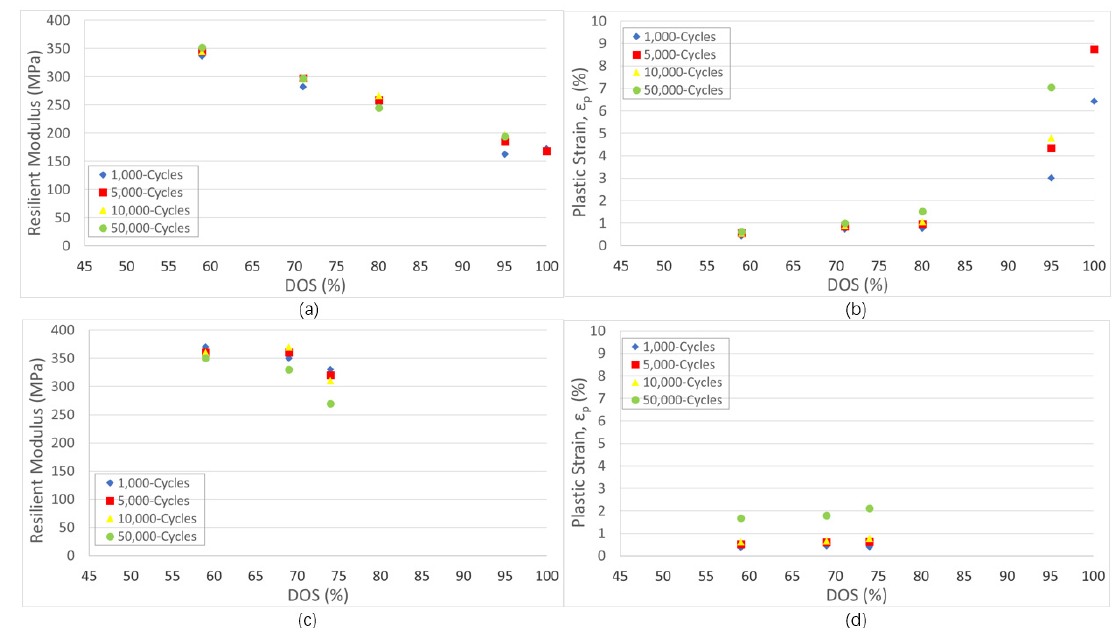
Figure 7. The relationship between the repeated load triaxial test (RLT) test results and DOS at a different number of cycles: ( a ) resilient modulus with applied deviator stress of 425 kPa; ( b ) plastic deformation with applied deviator stress of 425 kPa; ( c ) resilient modulus with applied deviator stress of 625 kPa; and ( d ) plastic deformation with applied deviator stress of 625 kPa.